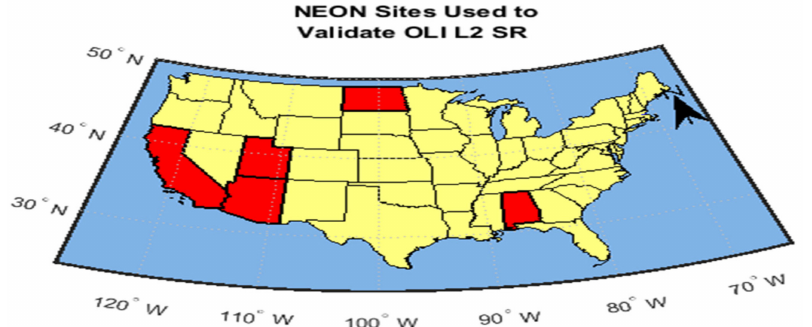
Figure 7. Distribution of the National Ecological Observatory Network (NEON) sites (highlighted in red) used in this study across the U.S generated using MATLAB [31].